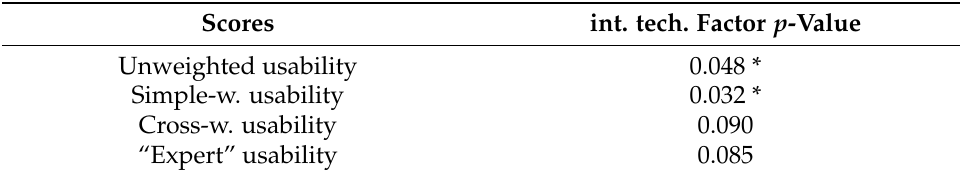
Table 6. Desktop application: between subjects—two-way ANOVA on usability scores with interac- tion technique and scenario